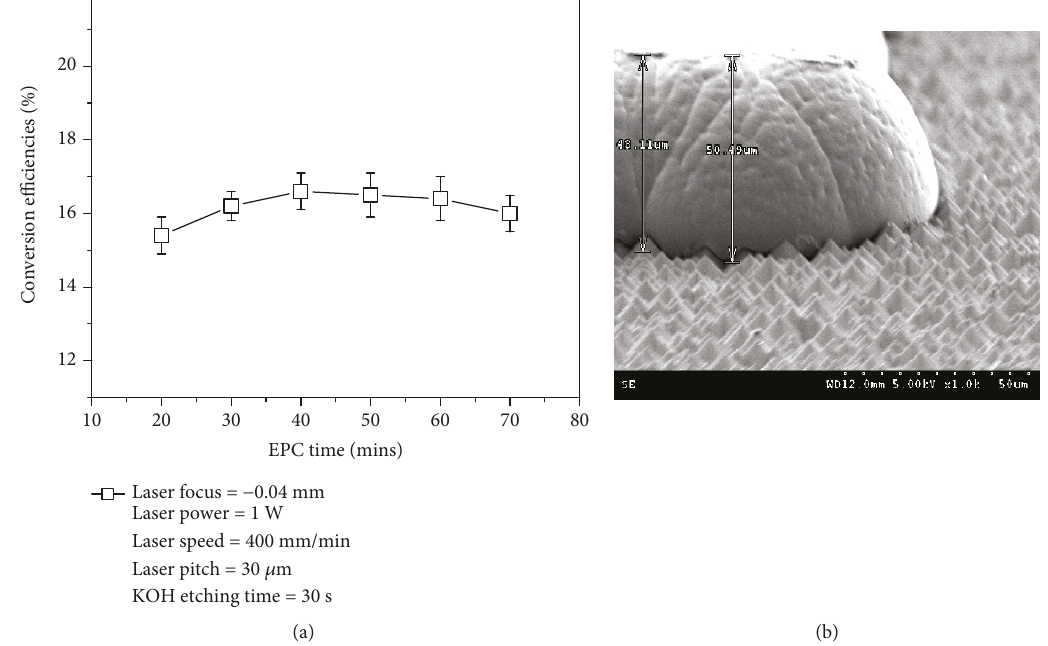
Figure 10: (a) Conversion e ffi ciency vs. EPC time curve of SPMSCs with a B-BSF seed layer and EPC contact layer as the rear contacts. (b) FESEM surface morphology images of backside surfaces of SPMSCs with an EPC time of 40 min.